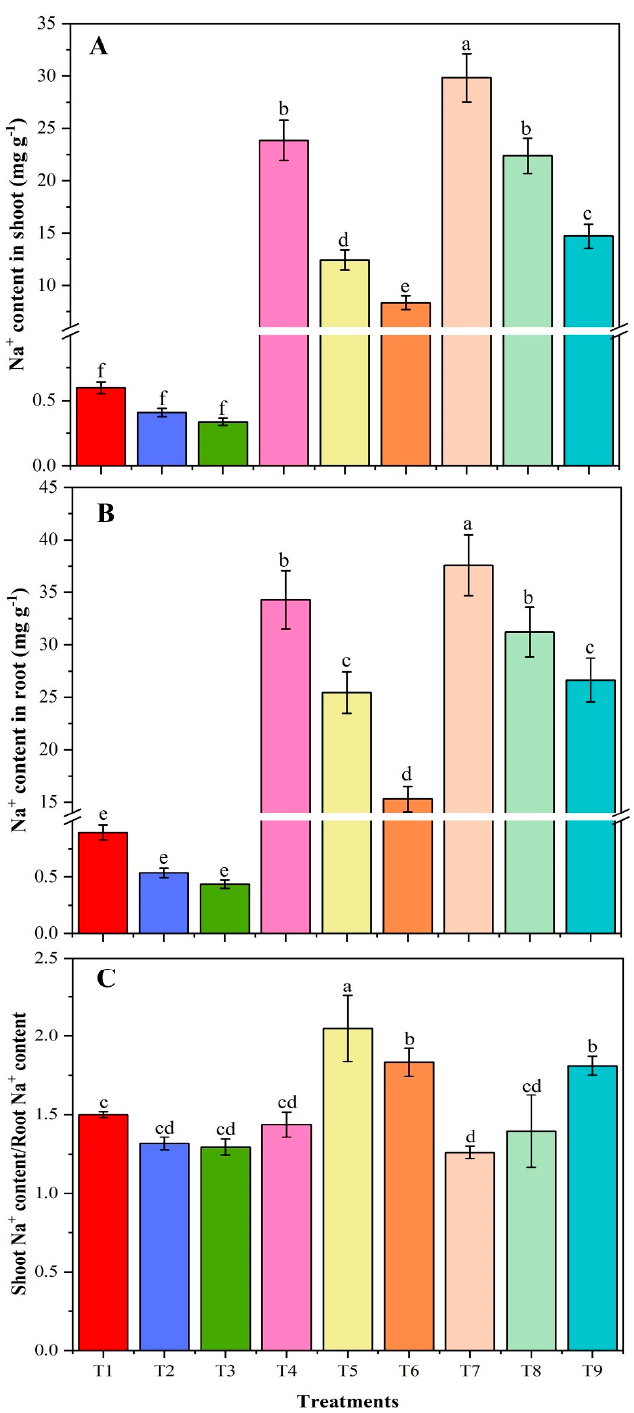
Figure 2. The sodium ion contents in the shoot ( A ) and root ( B ) and shoot / root ( C ) of un-amended and amended soybean plants with chitosan modified and as-is biochar under saline conditions. Data are shown as the mean ± standard deviation (n = 3). Di ff erent letters above the chart columns indicate significant di ff erences among treatments ( p ≤ 0.05). T1, control plants without NaCl, modified and as-is biochar treatments; T2, plants treated with as-is biochar; T3, plants treated with chitosan modified biochar; T4, plants treated with 40 mM NaCl; T5, plants treated with 40 mM NaCl and as-is biochar; T6, plants treated with 40 mM NaCl and chitosan modified biochar; T7, plants treated with 80 mM NaCl; T8, plants treated with 80 mM NaCl and as-is biochar; T9, plants treated with 80 mM NaCl and chitosan modified